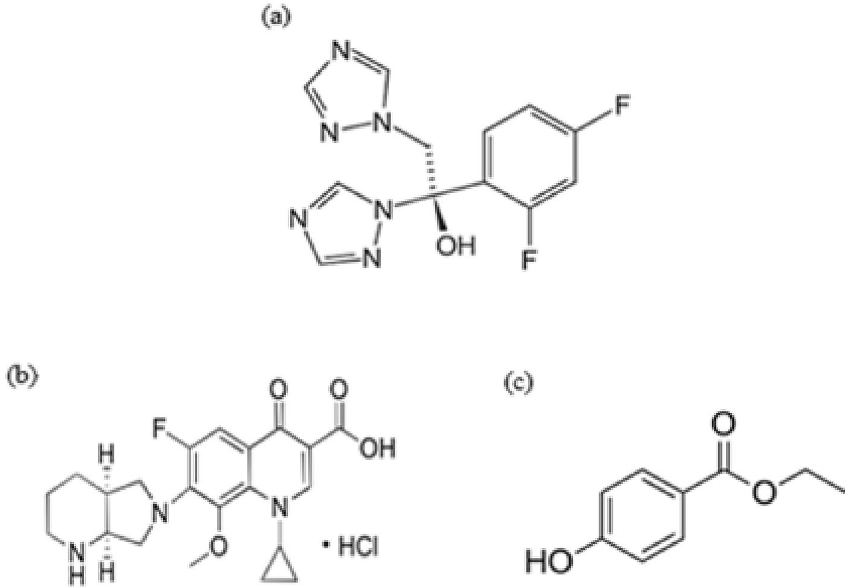
Figure 1. Structural formulae of: ( a ) FLZ. ( b ) MOX. ( c )